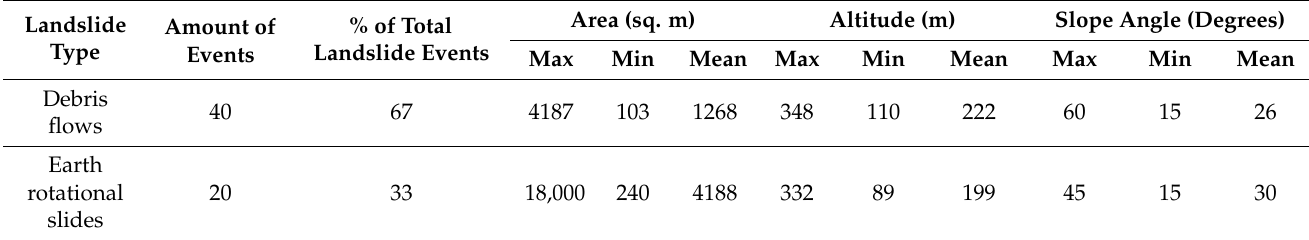
Table 1. Types and basic morphometrical parameters of the landslides in the study